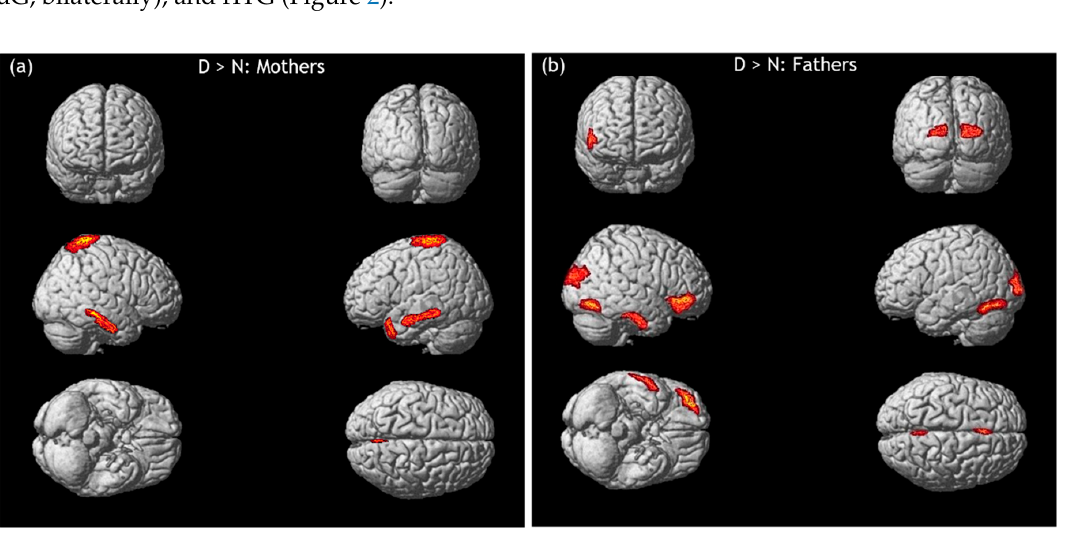
Figure 2. Cortical representation of the cluster of voxels in which the high − density electroencephalography (hdEEG) signal was higher in response to infant distressed emotions (D) than in response to neutral faces (N), in mothers ( a ) and fathers ( b ) respectively. Regional details